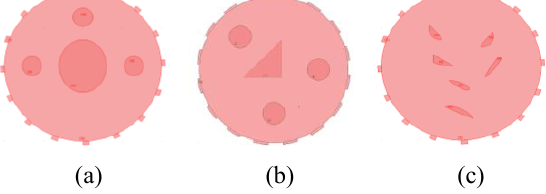
Fig. 2 . Three original artificial images. (a) A big and three small circles with the same permittivity. (b) A triangle and three circles with different permittivity. (c) Six peppers with the same permittivity. Table 1 . Reconstructed images and their